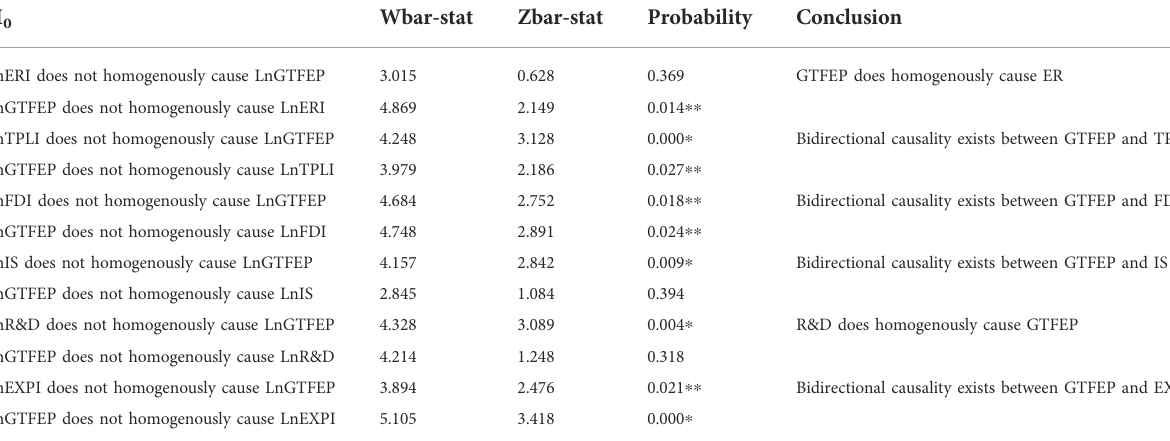
TABLE 6 Results of pairwise Dumitrescu and Hurlin panel causativeness analysis.